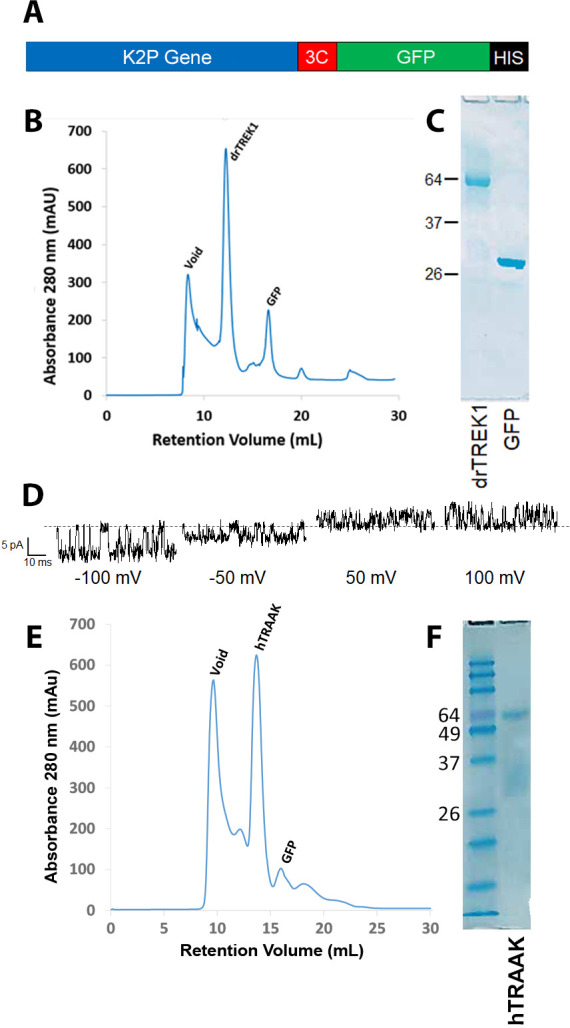
Purification of TREK1 and TRAAK proteins.(A) Zebrafish TREK1 or human TRAAK DNA sequences were purified by metal chromatography via a C-terminal HIS tag, and expressed as fusion proteins with GFP, cleaved off via a 3C protease cleavage site prior to (B,E) final size exclusion chromatography. (C, F) After SDS PAGE electrophoresis, purified protein ran at a molecular weight of approximately 65 kDa, consistent with a K2P dimer. Prior to photolabeling experiments, purified TREK1 protein was assessed for functional integrity by reconstitution into planar lipid bilayers to measure single-channel activity at the indicated holding potentials. Recordings were performed in symmetrical 150 mM KCl solution (D). hTRAAK protein was similarly active when reconstituted into bilayers (not shown).